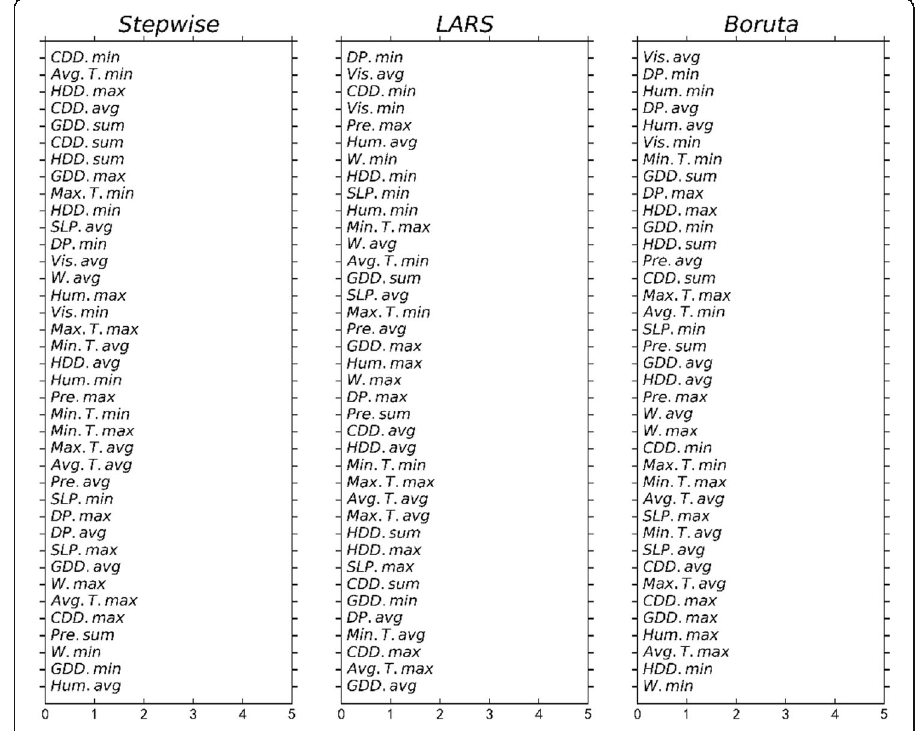
Fig. 2 The feature importance ranking of three variable filtering